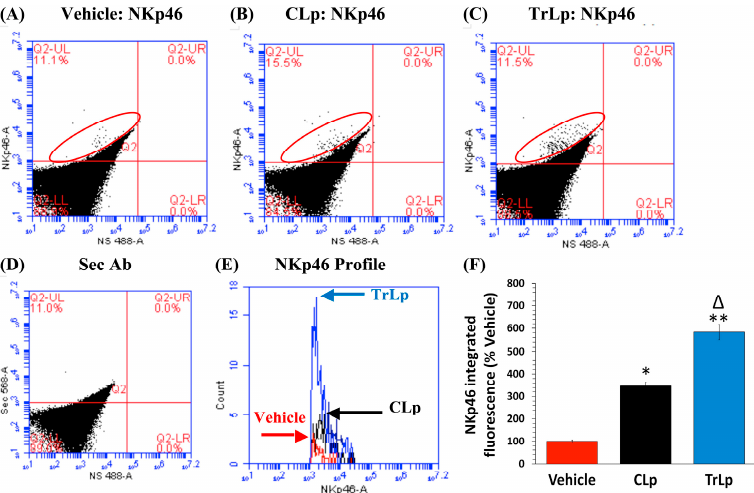
Figure 6. After a 5-day treatment of GBM mice, TrLp causes higher NK Cell recruitment than CLp. ( A , E , F ) GBM tumors from Vehicle-treated, GBM mice contained very small number of NKp46(+) activated NK cells; ( A – C , E , F ) Compared to the Vehicle-treated group, the CLp-treated samples (UL, red ellipse) showed a 247% increase in NKp46 IF (* p = 1.8 × 10 − 4 ) and the TrLp-treated samples displayed 484% higher NKp46 IF (** p = 3.7 × 10 − 4 ) ( E , F ); ( F ) Thus the TrLp group showed 237% higher augmentation NKp46 IF than the CLp mice ( Δ p = 8.0 × 10 − 3 ). Data (mean ± S.E.M.) obtained from Vehicle ( n = 3 mice), CLp ( n = 3 mice) and TrLp ( n = 3 mice); ( D ) 2° antibody-treated samples showed background staining.